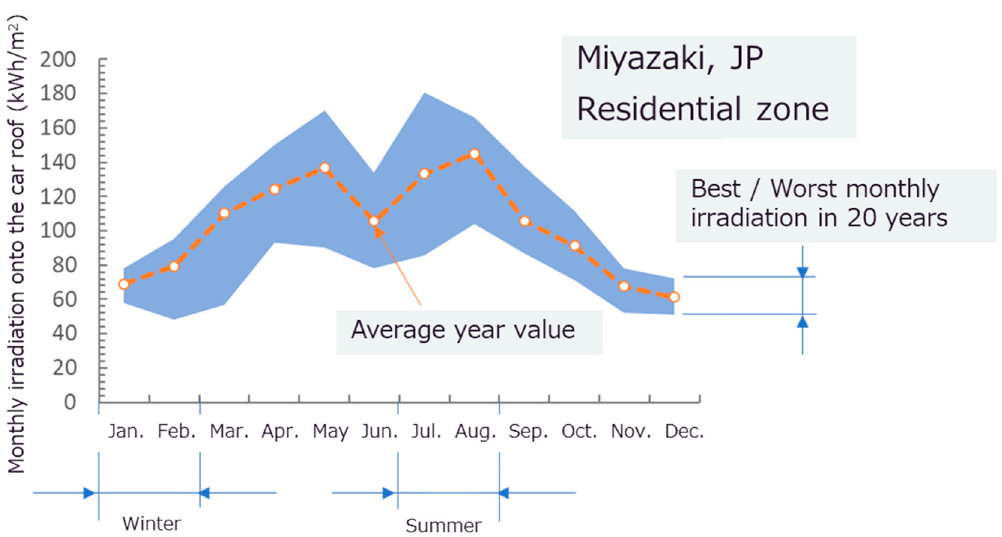
Figure 14. Solar irradiation of Miyazaki, Japan, the community on which the Monte Carlo simulation was based.